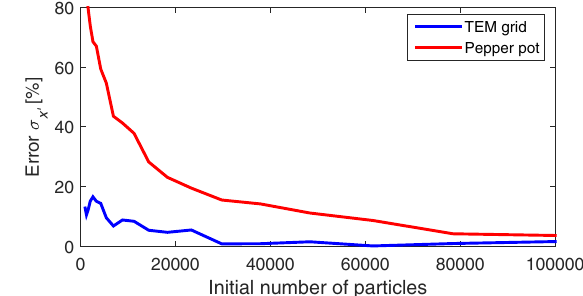
FIG. 3. Relative error of the rms divergence σ simulations of a fixed phase space distribution, as a function of the number of particles in the beam, intercepted by one bar of a TEM grid ( 85 μ m pitch, 31 μ m bar width) and one hole of a pepper pot mask ( 15 μ m hole diameter).